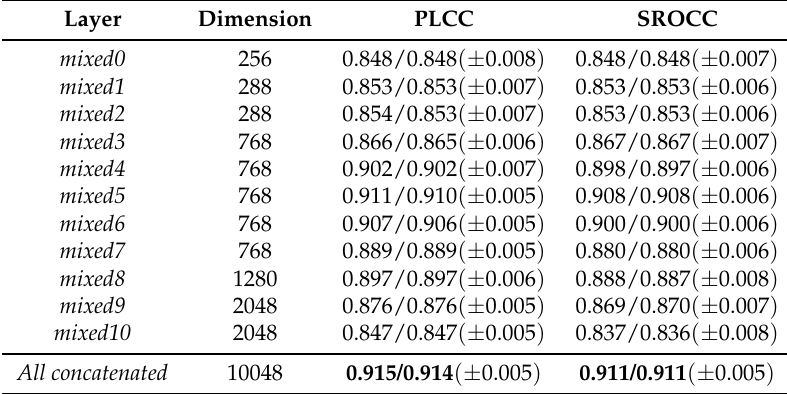
Table 4. Performance comparison of deep features extracted from Inception-V3’s [32] Inception modules with fine-tuning measured on KonIQ-10k [33]. Average/median ( ± std ) values are reported over 20 random train–validation–test splits. The best results are in bold